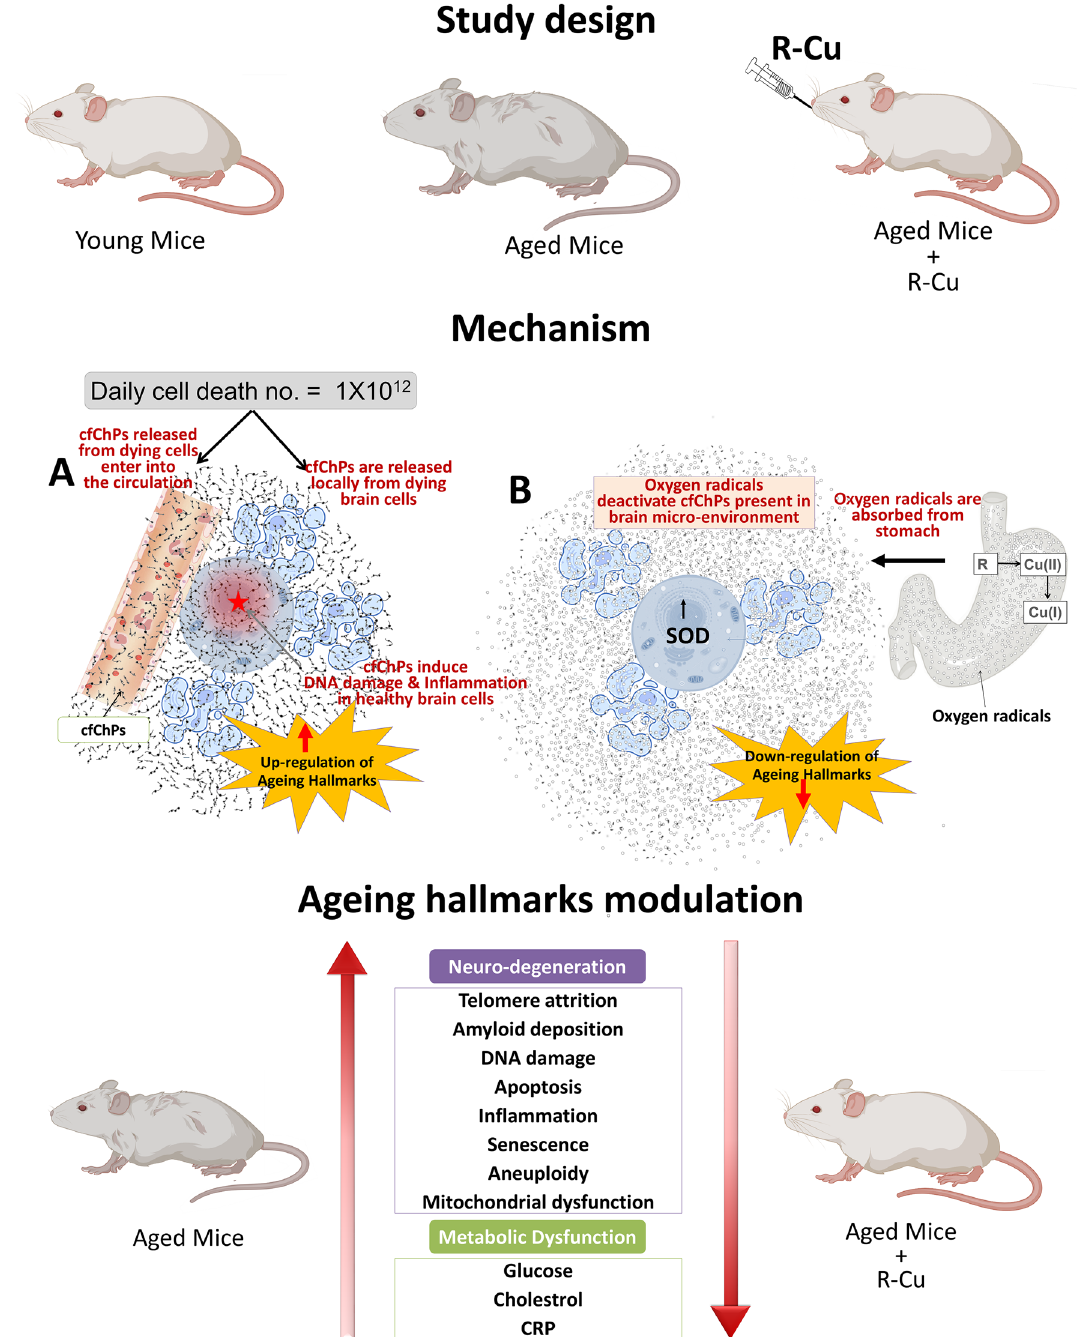
Figure 10. Graphical illustration of the study design and the mechanisms involved in oxygen radical induced down-regulation of biological hallmarks in ageing in brain cells following R–Cu treatment. ( A ) cfChPs that diffuse out from circulation, or those that are released locally from dying brain cells, are readily internalised by healthy brain cells, wherein they activate multiple biological hallmarks of ageing. ( B ) Oxygen radicals are generated in the stomach upon oral administration of R–Cu which are readily absorbed leading to systemic effects in the form of deactivation/eradication of cfChPs in the brain micro-environment. Deactivation/ eradication of cfChPs leads to down-regulation of biological hallmarks of ageing in brain cells. Oxygen radicals also enter into the healthy brain cells; but their entry leads to activation of the anti-oxidant enzyme superoxide dismutase (SOD), which detoxifies and eliminates the offending agents, thereby protecting the genomic